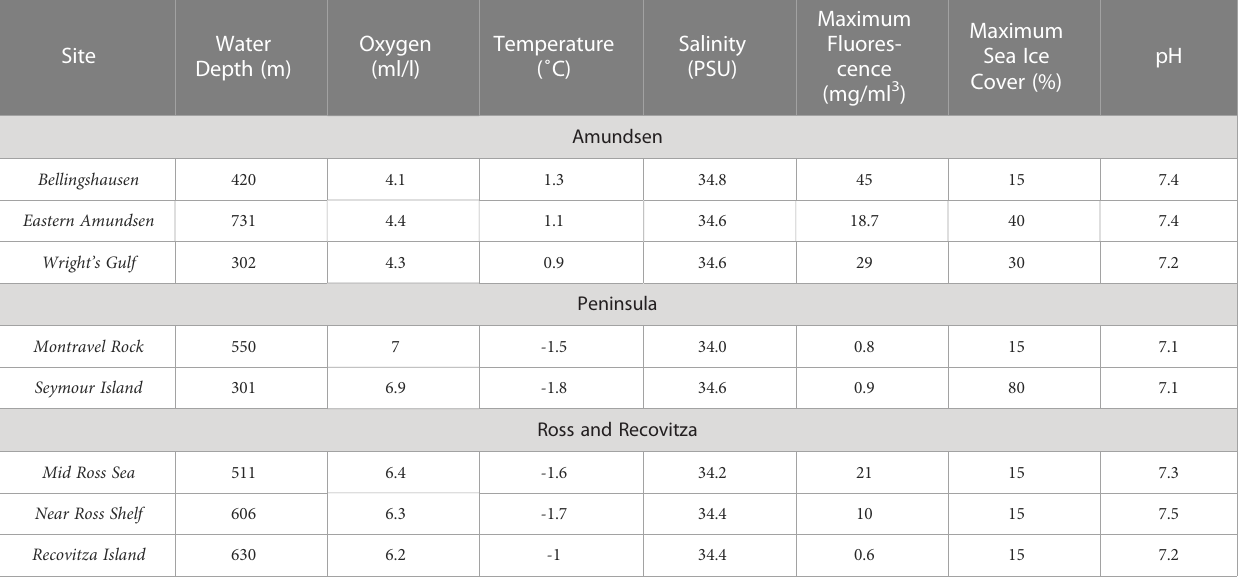
TABLE 4 Environmental characteristics for each site in each